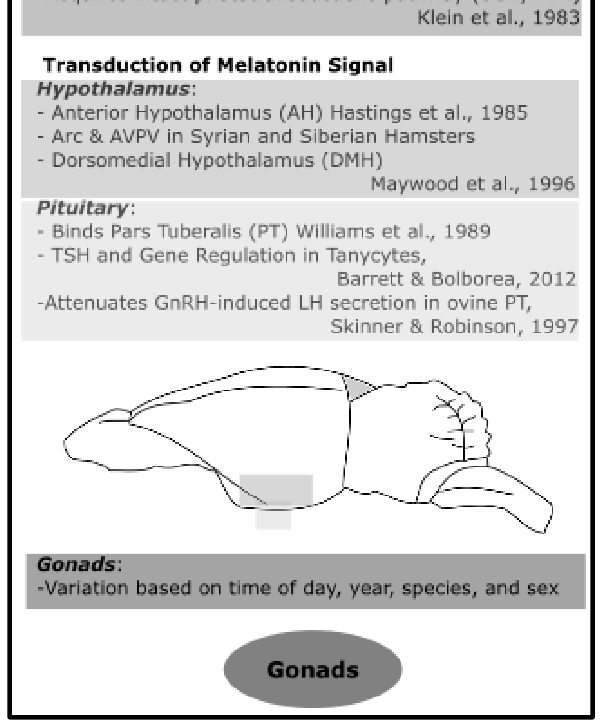
Figure 5. Summary of major findings on melatonin in the mammalian HPG axis.